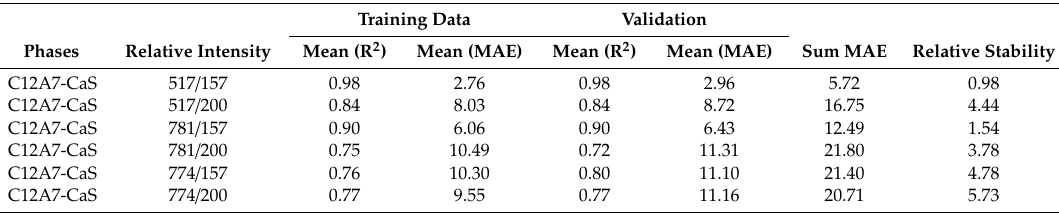
Table 6. Evaluation of the coe ffi cient of determination (R 2 ) and mean absolute error (MAE) for the prediction and validation between the phase content and relative intensity of the Raman peaks and phase content for C12A7–CaS.